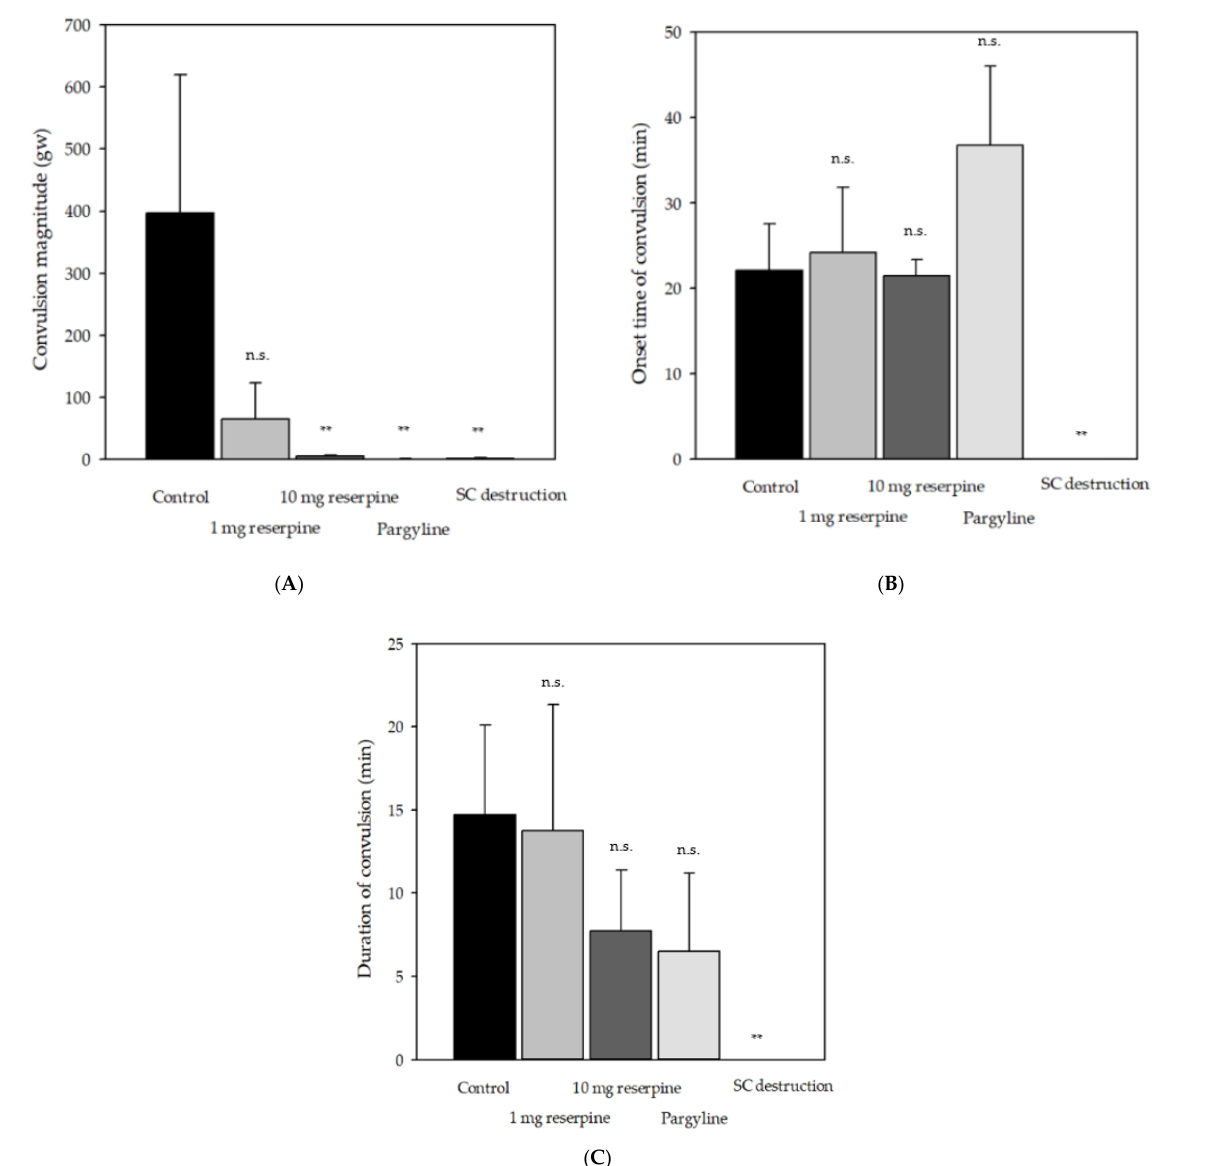
Figure 2. The comparison of delayed convulsion patterns of red seabreams subjected to indicative treatments: ( A ) the magnitude of convulsion, ( B ) the latency time of convulsion, and ( C ) the duration of convulsion. Indicative treatments were applied to the red seabreams ( Pagrus major ) before (reserpine or pargyline) or after spinal cord destruction (SCD) cranial spiking (CS). Values represent mean ± SD of nine individuals. Statistically significant difference is shown as * p < 0.05, ** p < 0.01. Not significant, n.s.